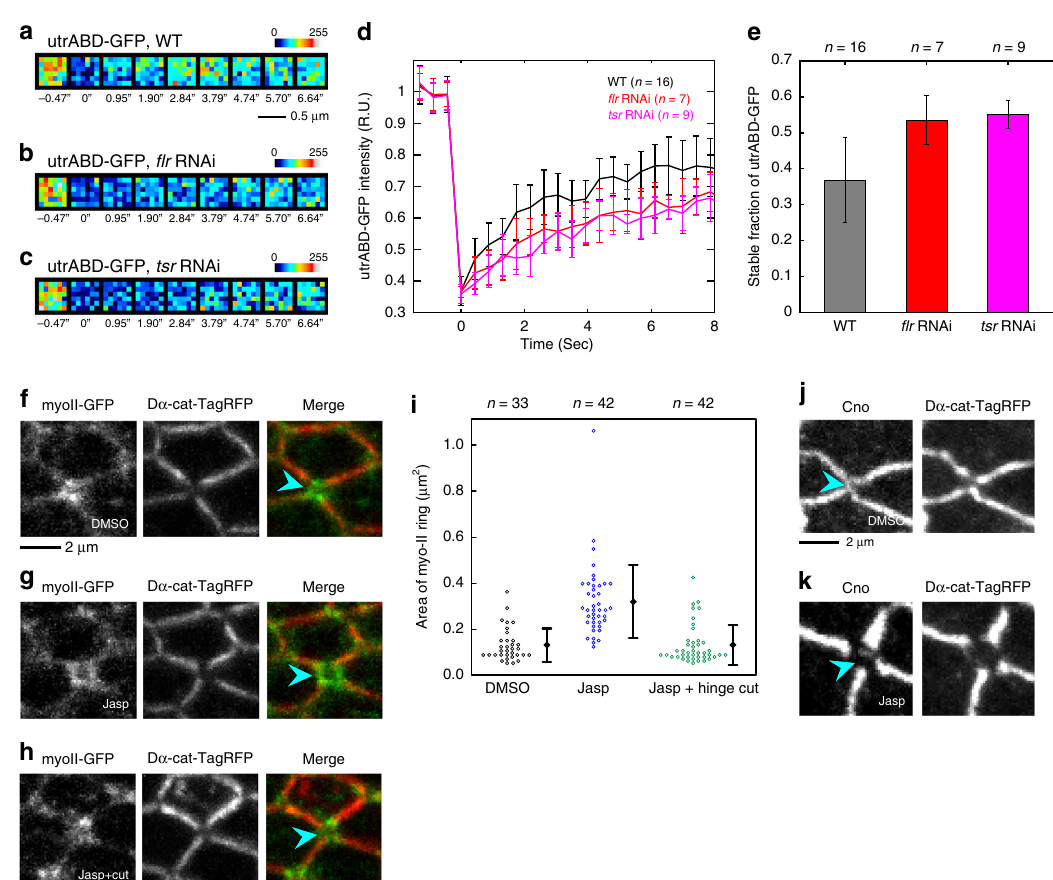
Fig. 8 Actin turnover underlies the reorganization of actomyosin and cell adhesion. a – c utrABD-GFP in ROIs examined before and after photobleaching in the wings with the indicated genotypes ( a WT at 24 h APF; b , fl r RNAi at 24 h APF; and c , tsr RNAi at 20.5 h APF at 29 °C, which corresponds to ~24 h APF at 25 °C). Color maps are shown in the upper right. d Recovery of utrABD-GFP signal intensity after photobleaching at AP junctions (black, WT; red, fl r RNAi; magenta, tsr RNAi). utrABD-GFP signal intensity was normalized by its average value at three time points prior to photobleaching. The average of the data from individual junctions is plotted. e The stable fraction of utrABD-GFP for each genotype. Steel test: WT vs. fl r RNAi, P < 0.01, WT vs. tsr RNAi, P < 0.001. f – h Images of myo-II-GFP (gray in left panels, green in right panels) and D α -cat-TagRFP (gray in middle panels, red in right panels) in a DMSO- treated wing ( f ), Jasp-treated wing ( g ), and Jasp-treated wing, which were detached from their hinges at 15 h APF ( h ). All images were acquired at 24 h APF. Blue arrowheads indicate myo-II rings. i The myo-II ring area is plotted for each condition. Steel – Dwass test: DMSO vs. Jasp, P < 0.001, DMSO vs. Jasp + hinge cut, P > 0.8, Jasp vs. Jasp + hinge cut, P < 0.001. j , k Images of Cno (left) and D α -cat-TagRFP (right) in DMSO-treated ( j ) and Jasp-treated ( k ) wings at 24 h APF. Blue arrowheads indicate the short AP junctions. The number of junctions examined ( d , e ) and the number of ROI examined ( i ) are indicated. Data are presented as the mean ± s.d. ( d , e , i ). Scale bars: 0.5 µ m ( a ) and 2 µ m ( f , j